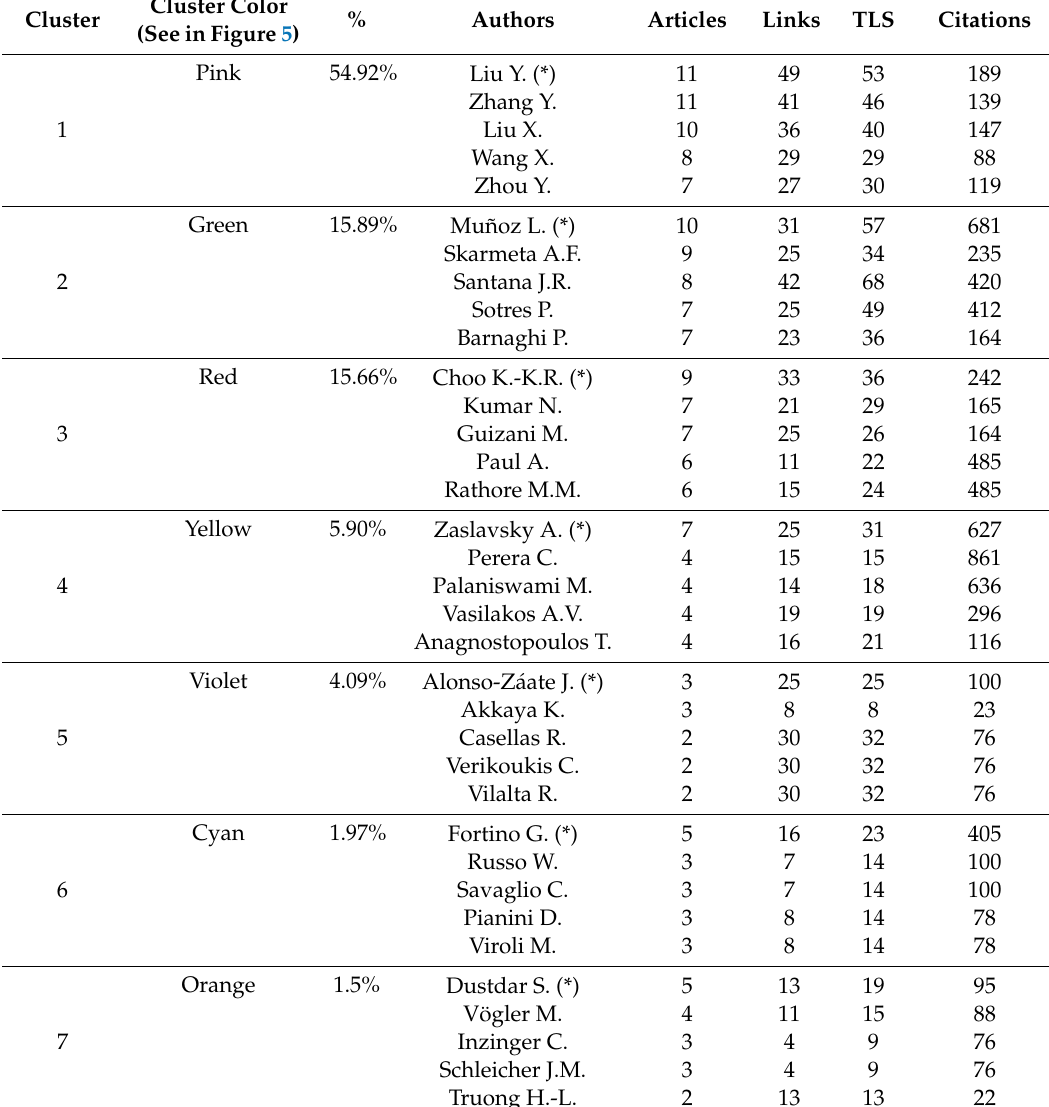
Table 12. Clusters of authors